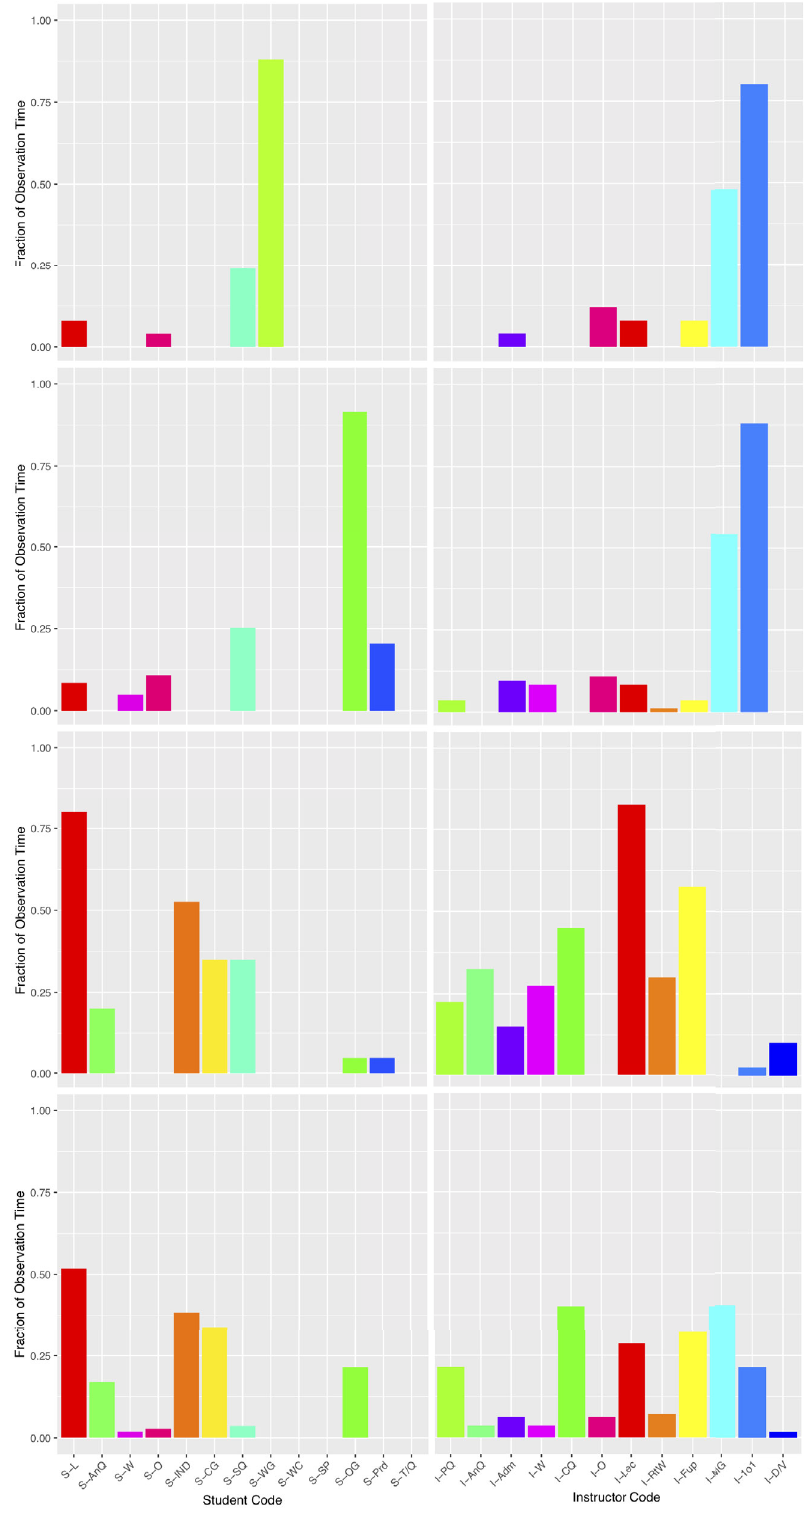
FIG. 5. Top row: Context-Rich Problems, discussion section. Second row: Context-Rich Problems, lab section. Third row: Context- Rich Problems, lecture section. Last row: